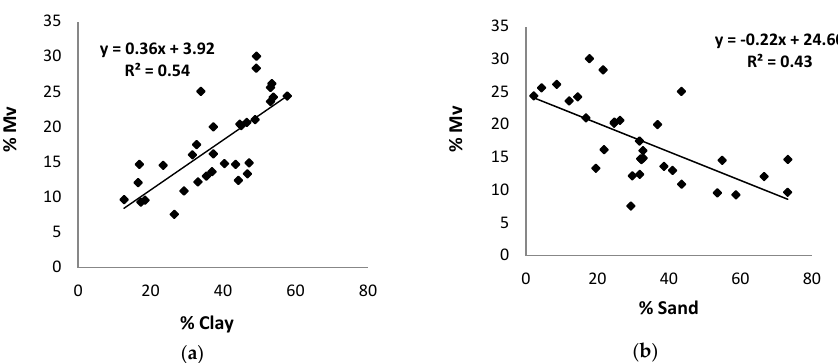
Figure 8. Temporal mean of soil moisture over the reference fields, computed for the period between September and the beginning of December as a function of soil texture computed from ground measurements: ( a ) for clay content; ( b ) for sand content.